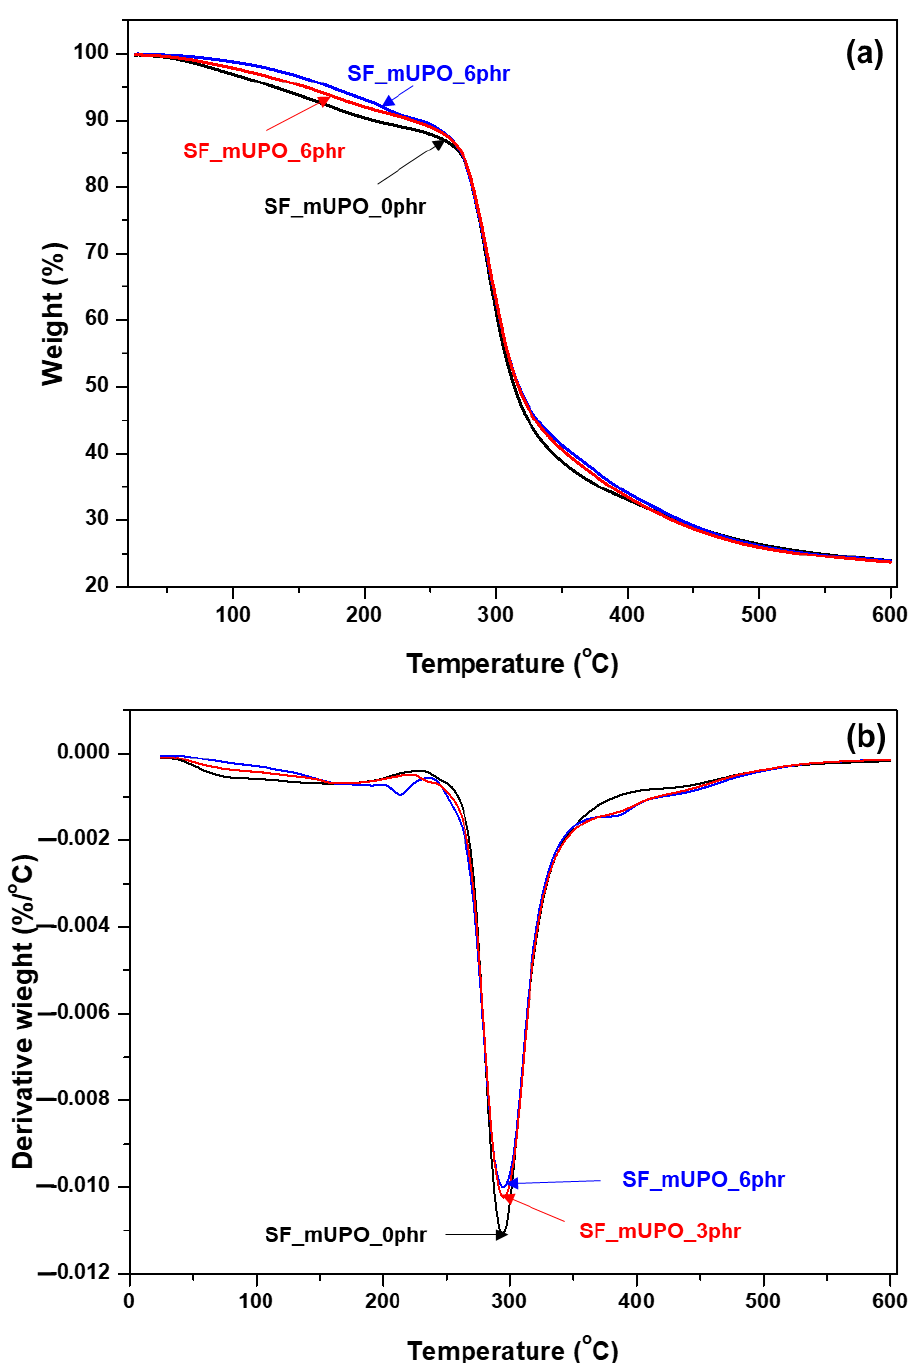
Figure 8. Thermogram of non-glutinous starch foam with various mUPO content — 0, 3, and 6 phr — ( a ) TGA and ( b ) DTG.